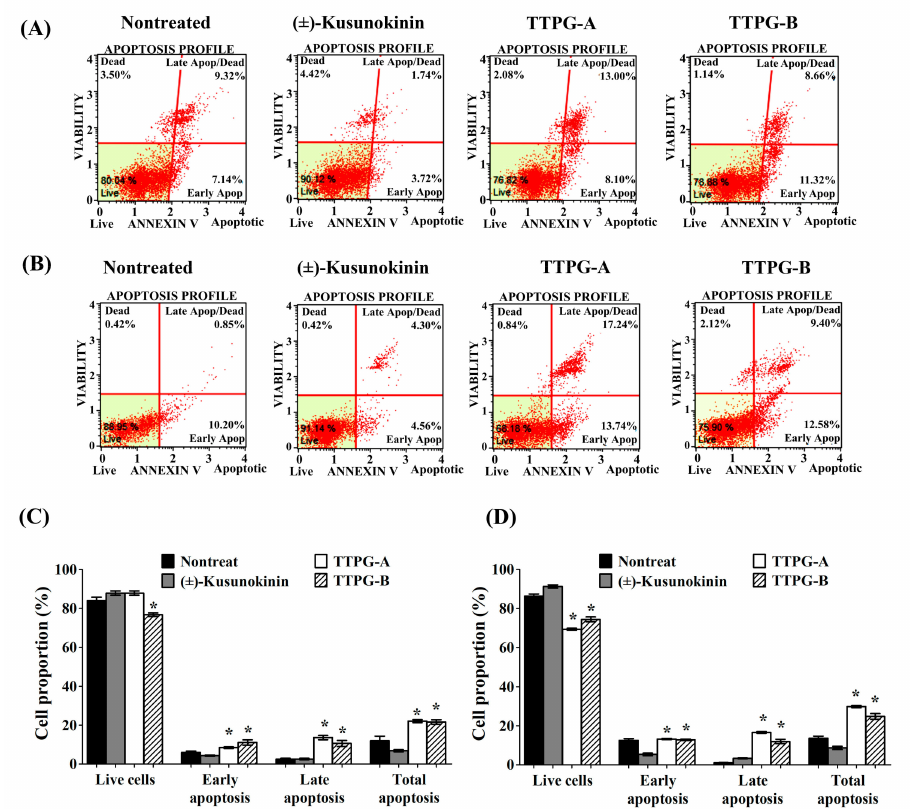
Figure 3. ( ± )-TTPG-A and ( ± )-TTPG-B induced apoptosis. ( A ) KKU-M213 cells were incubated with ( ± )-Kusunokinin, ( ± )-TTPG-A and ( ± )-TTPG-B at 4.47, 0.07 and 0.01 µ M, respectively, for 72 h, and nontreated cells served as control. ( B ) Cells were treated with ( ± )-kusunokinin, ( ± )-TTPG-A and ( ± )-TTPG-B at 0.15 µ M, and incubated for 48 h. After treatment, apoptotic cells were analyzed using the Muse ®® Annexin V-FITC assay and Propidium Iodide (dead-cell kit). The results of this experiment were analyzed using flow cytometry. Each plot has four quadrant markers. The lower-left and lower-right represent live and early-apoptotic cells, respectively. The upper-left and upper-right quadrants are dead cells (necrosis) and late-apoptotic/dead cells, respectively. ( C , D ) The graph represents the summary of average percentages ± SD of live, early-apoptotic, late-apoptotic and total-apoptotic cells from three independent experiments. The statistical analysis of the data was tested using Student’s t -test. * Indicates p values less than 0.05 which were considered as significant differences, compared with the control